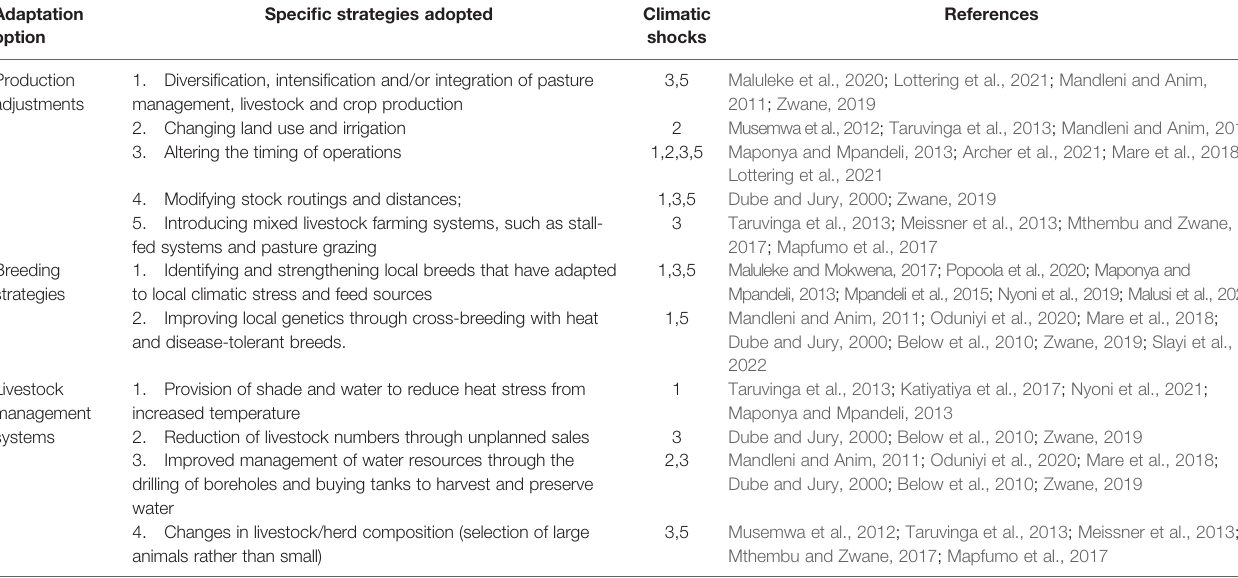
TABLE 2 | Summary of adaptation options in response to climatic shocks in livestock from existing literature in rural communities of South Africa.